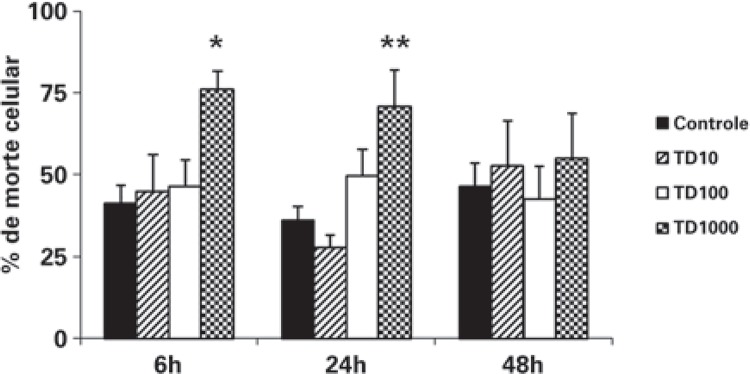
Células mortas após incubação por 6, 24 e 48 horas, em doses de 10, 100 e 1.000µg/mL de extrato Turnera diffusa